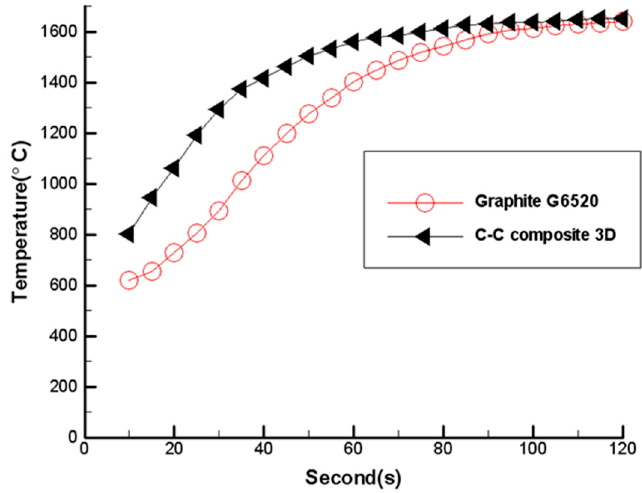
Figure 8. Comparison of surface temperature of Graphite G6520 and the 3D C–C composite.